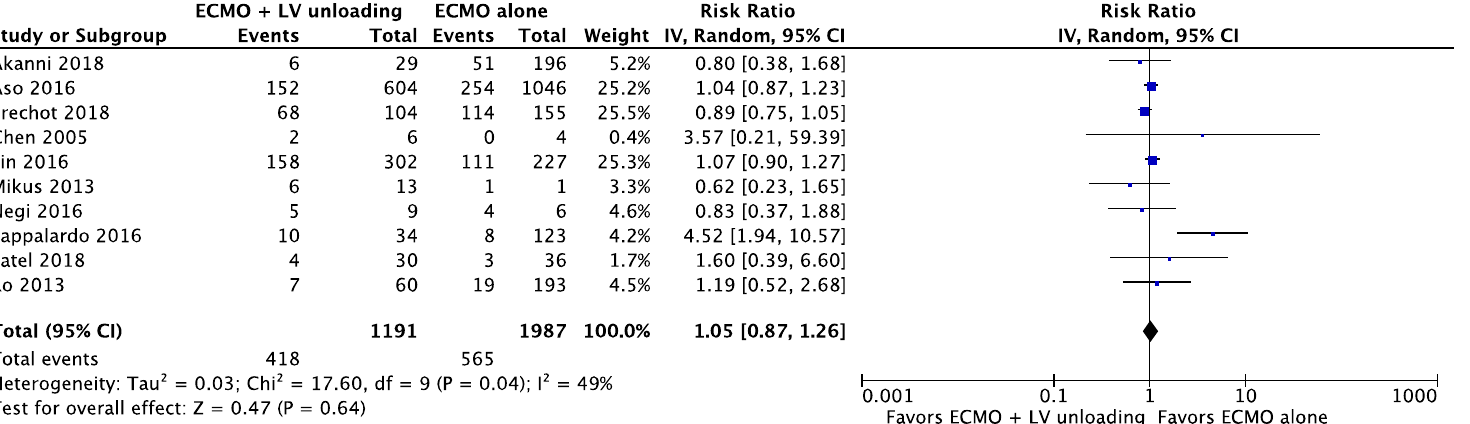
Figure A9. Acute kidney injury (AKI).